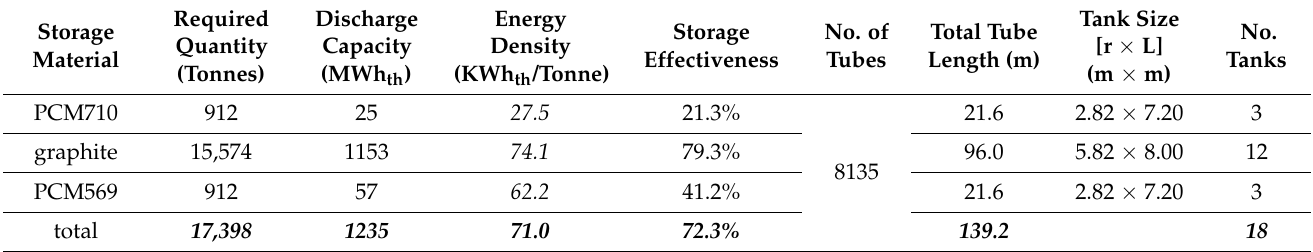
Table 4. Design specifications of the hybrid TES system.